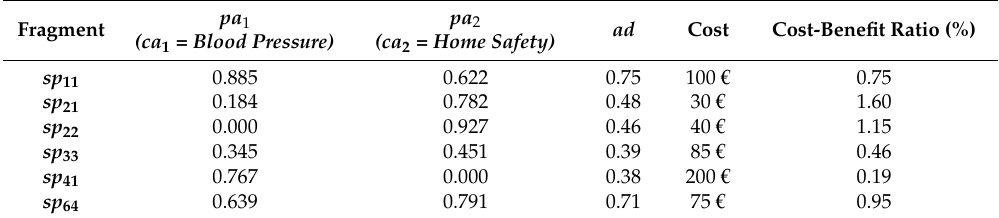
Table 10. Mr. Silva’s Solution’s